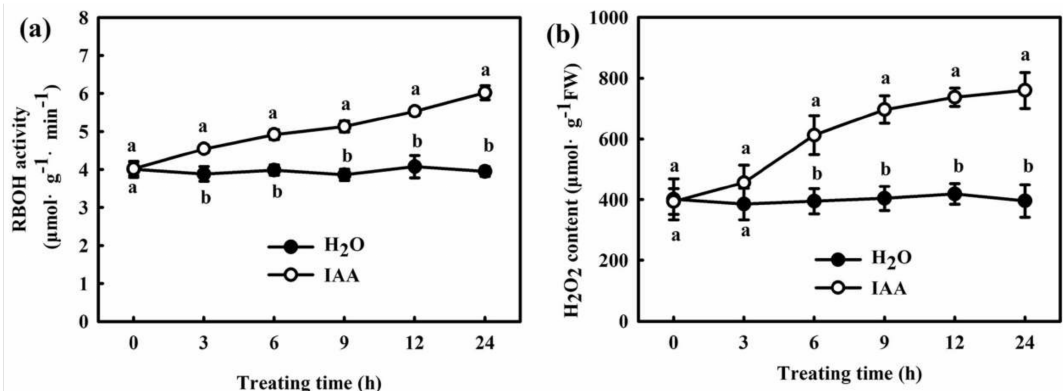
Figure 6. Effect of IAA on the RBOH activity ( a ) and H 2 O 2 accumulation ( b ) in cucumber seedlings. Cucumber seedlings were foliar sprayed with 75 µ M IAA or deionized water (control), and then, we measured the changes of RBOH activity and H 2 O 2 content within 24 h. The data represent the mean ± SD of three biological replicates. Different letters indicate significant differences ( p < 0.05), according to Duncan’s new multiple range test.